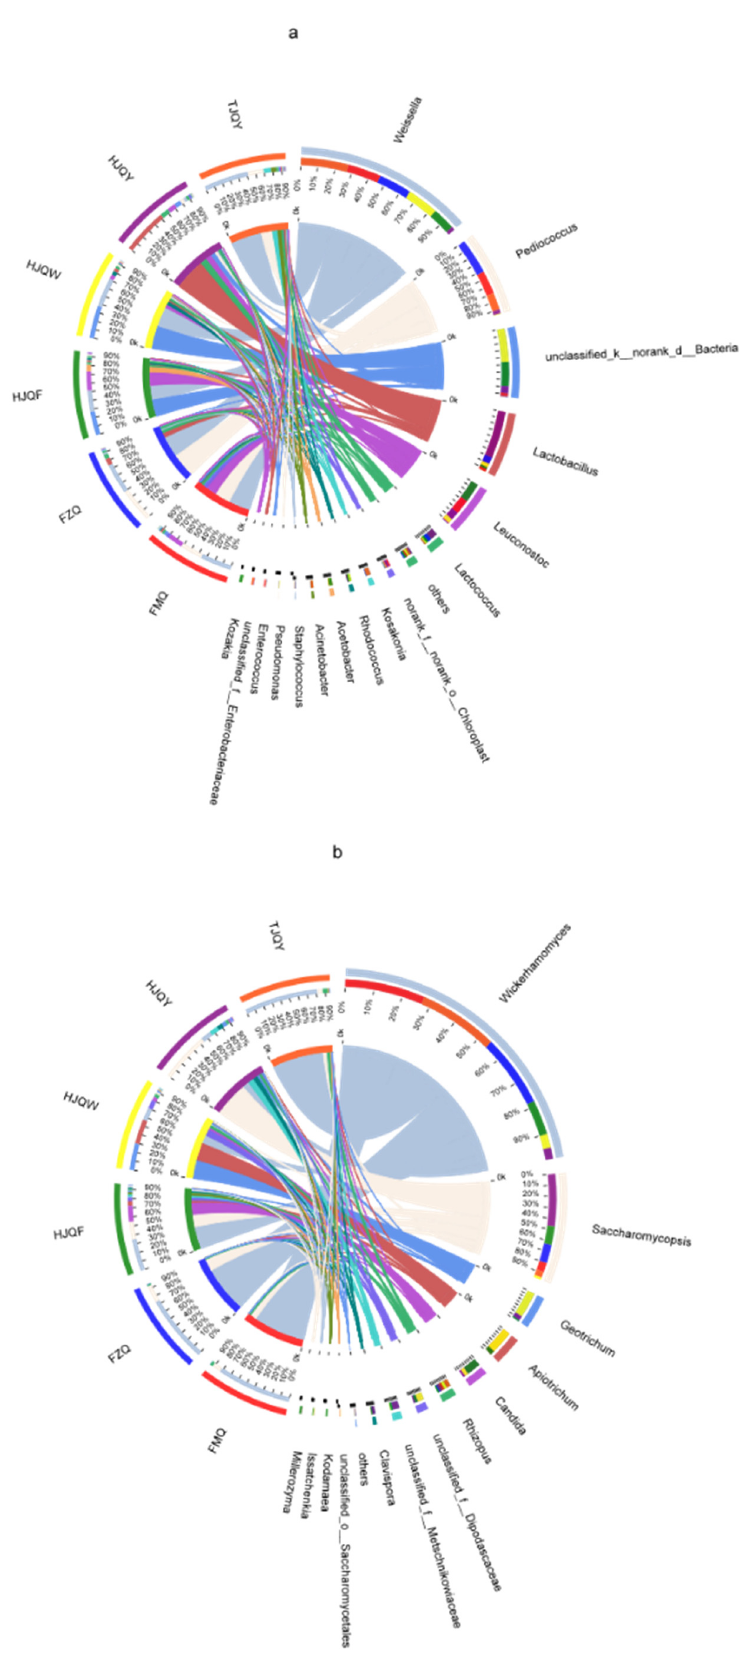
Figure 2. Microbial community composition at the genus level of JIUYAO; ( a ) relative abundance of bacteria; ( b ) relative abundance of